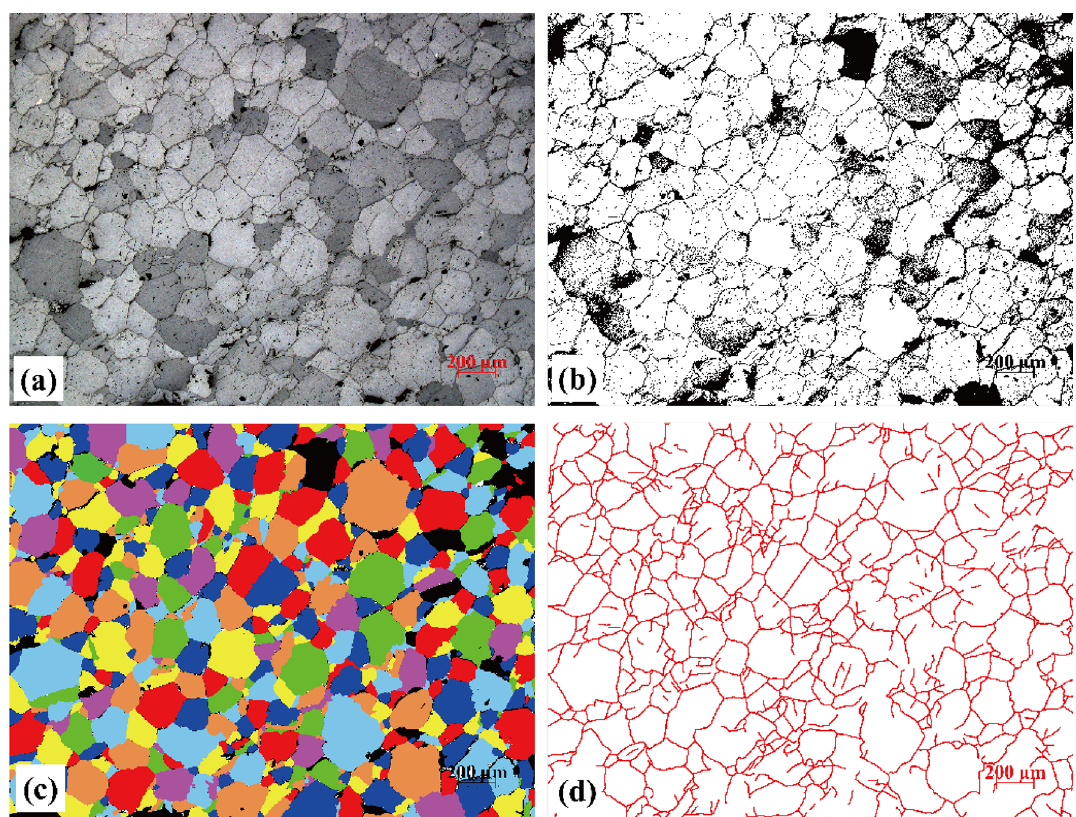
Figure 11. Improved image processing procedures for mesoscopic analysis of images taken from the optical microscope observation tests of a rock sample after 600 °C thermal treatment. The original image ( a ) was reverse-segmented and converted to grey image ( b ), in which the grains were filled with different colors ( c ). Image ( d ) shows the curves that represent the micro-cracks in image ( a